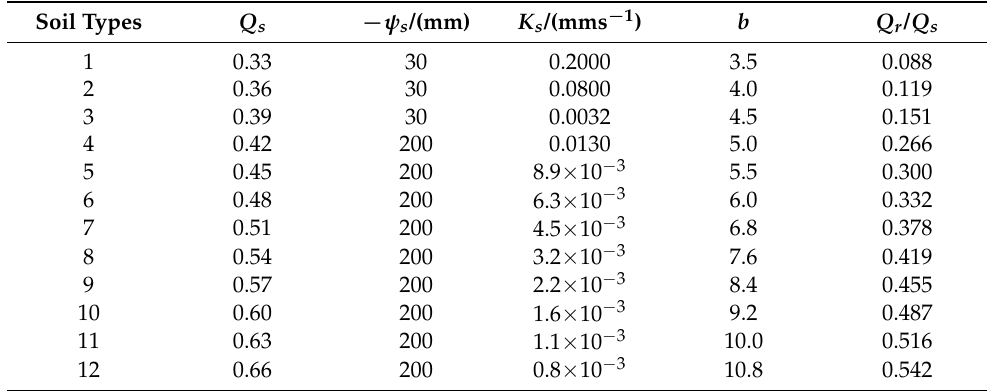
Table 1. Twelve soil parameters in unsaturated water flow